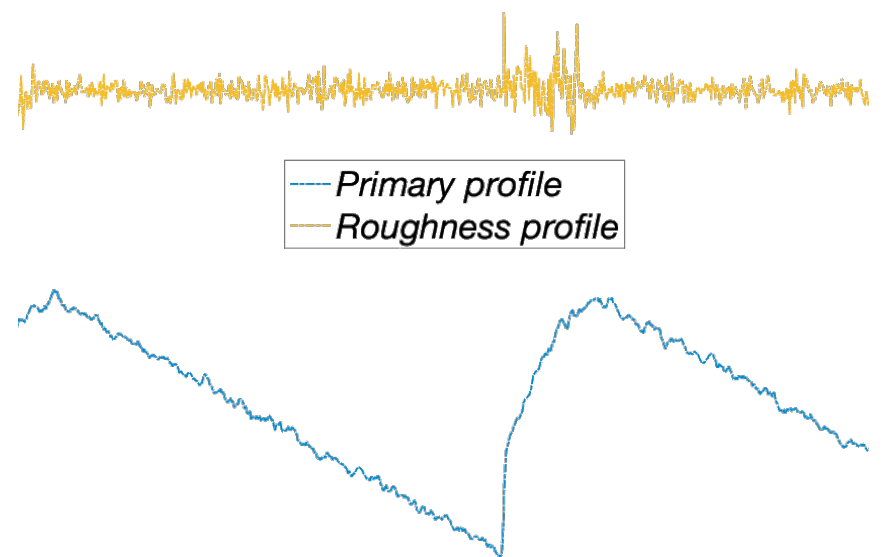
Figure 8. Qualitative plots describing the primary profile and roughness profiles, as defined by ISO 4287 [60], of the real profile of an AM component characterized by a significant stair-stepping